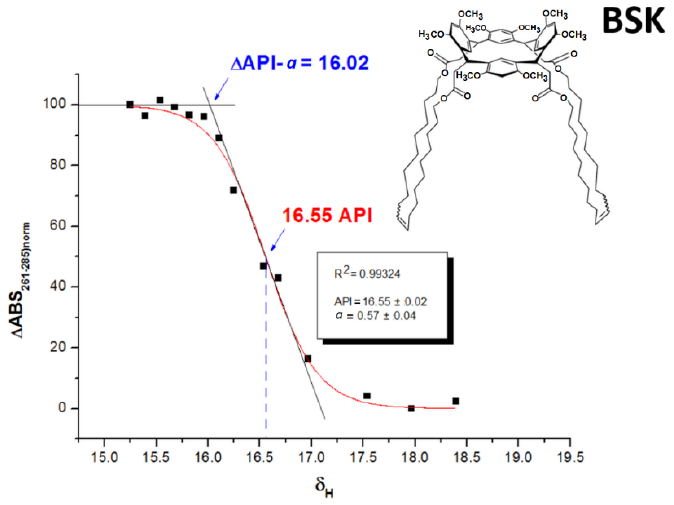
Figure 2. Sigmoidal aggregation profile of BSK as obtained in THF/water solvent system. The API parameter estimated for BSK from linear fitting of sigmoidal plot of ∆ ABS 350–400 vs. δ H is reported.